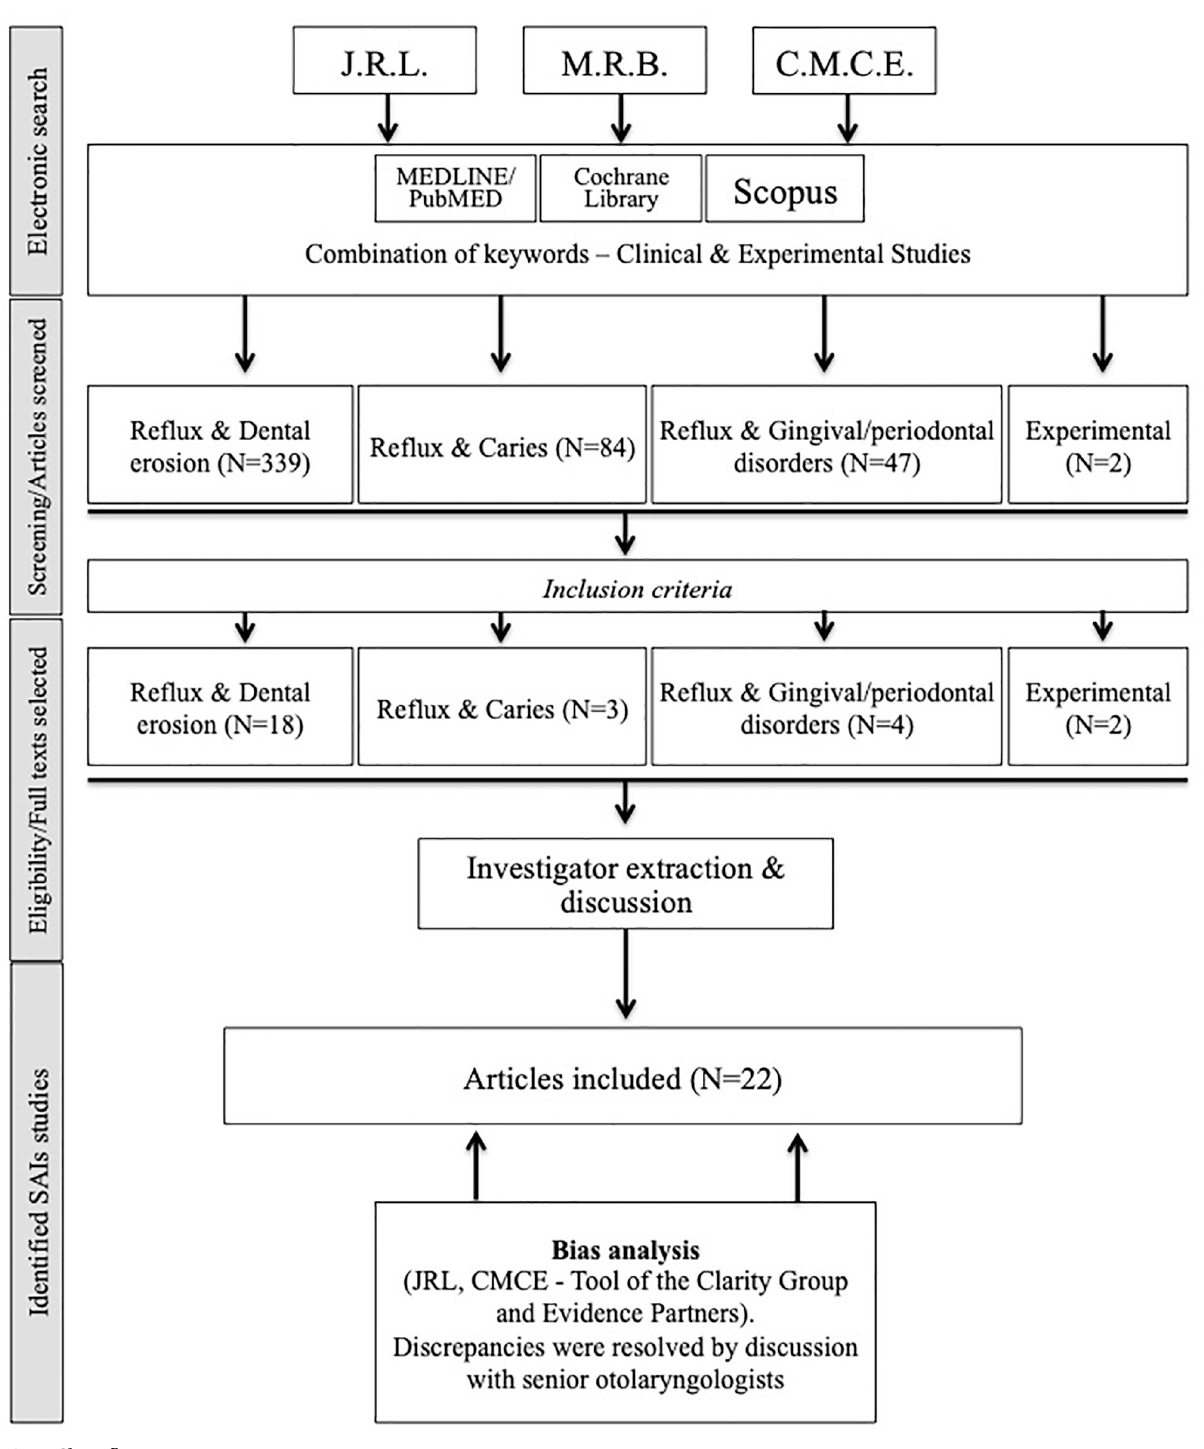
Fig 1. Chart flow.